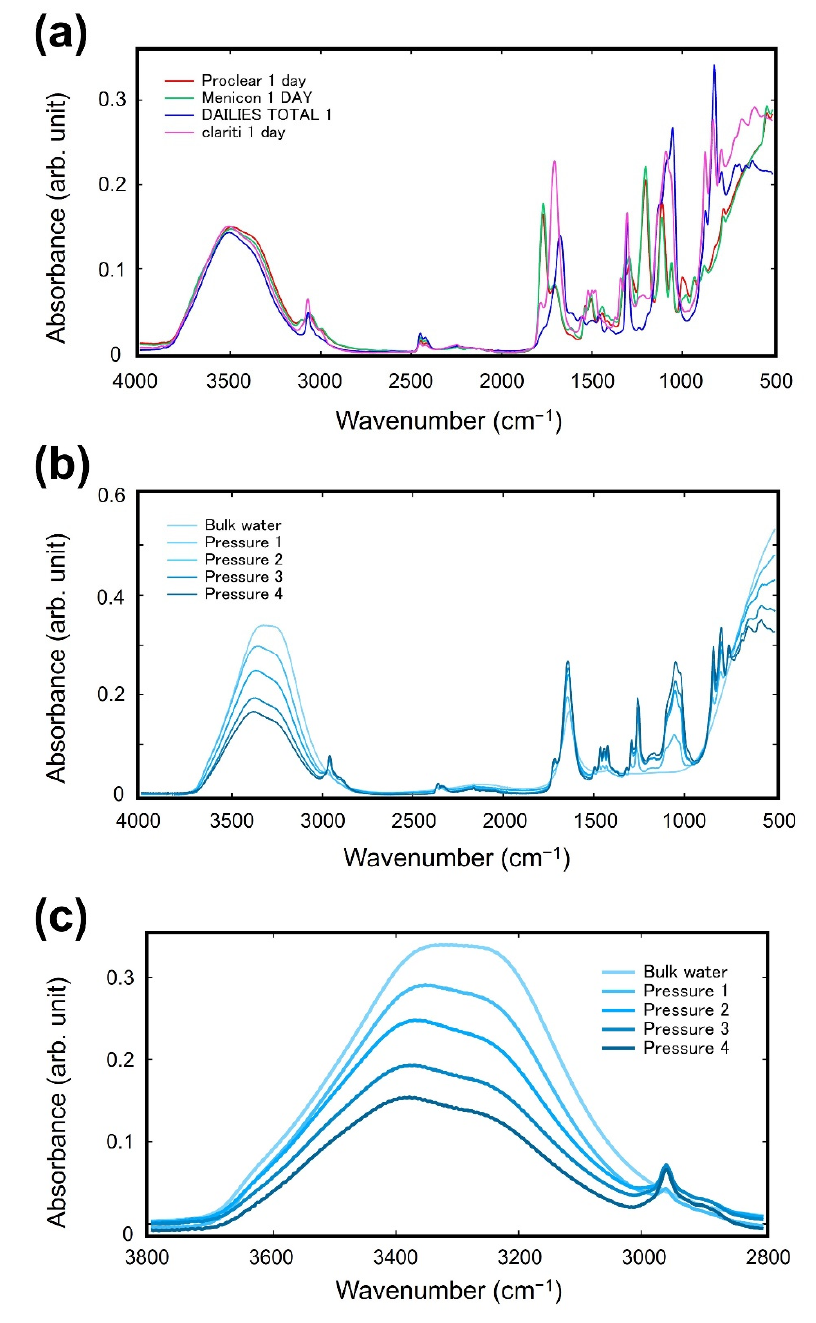
Figure 4. ( a ) ATR-IR spectra of the SCLs in the whole measuring range with applying pressure 4; ( b ) ATR-IR spectra in the whole measurement region under different pressures. (clariti ® 1 day) ( c ) ATR-IR spectra in the region of the OH stretching band under different pressures (clariti ® 1 day). The MCR-ALS process also provides the ratio of the components (in this case bulk